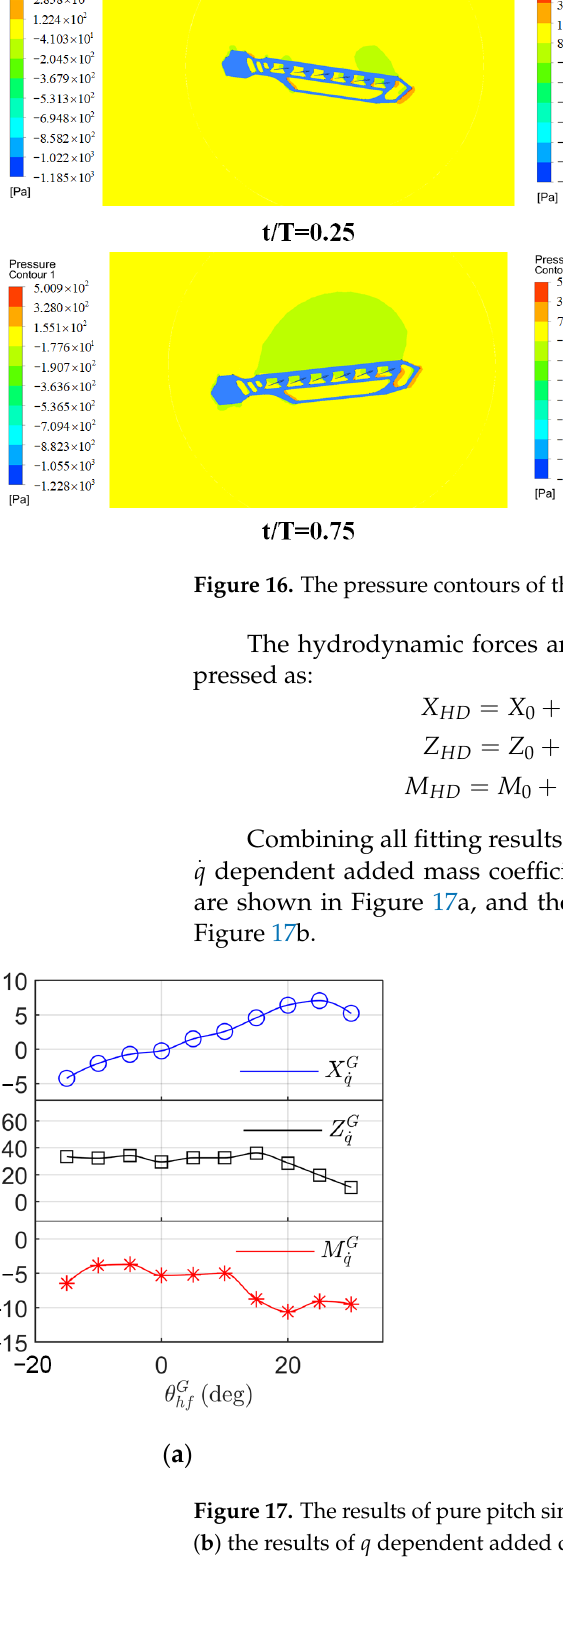
Figure 17. The results of pure pitch simulation: ( a ) the results of q  dependent added mass coefficients; ( b ) the results of q dependent added damping coefficients.